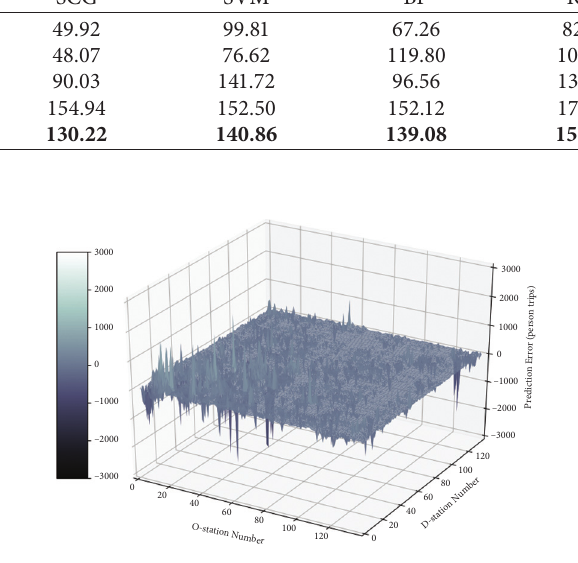
Figure 6: Prediction deviation of the proposed model on the National Day.